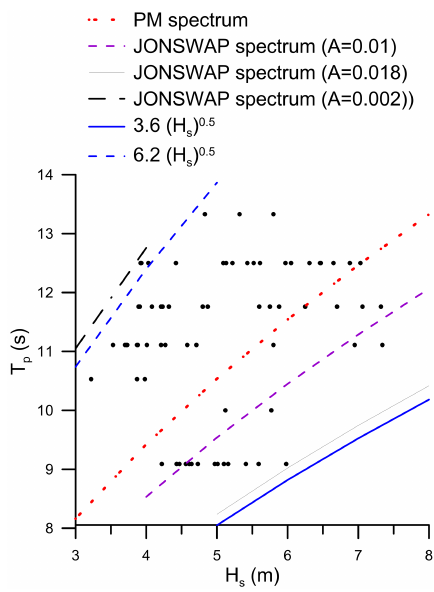
Figure 15. Variation of peak wave period ( T p ) with significant wave height ( H s ) during 11–12 October 2013. The various theoretical for- mulations are also presented in the figure.